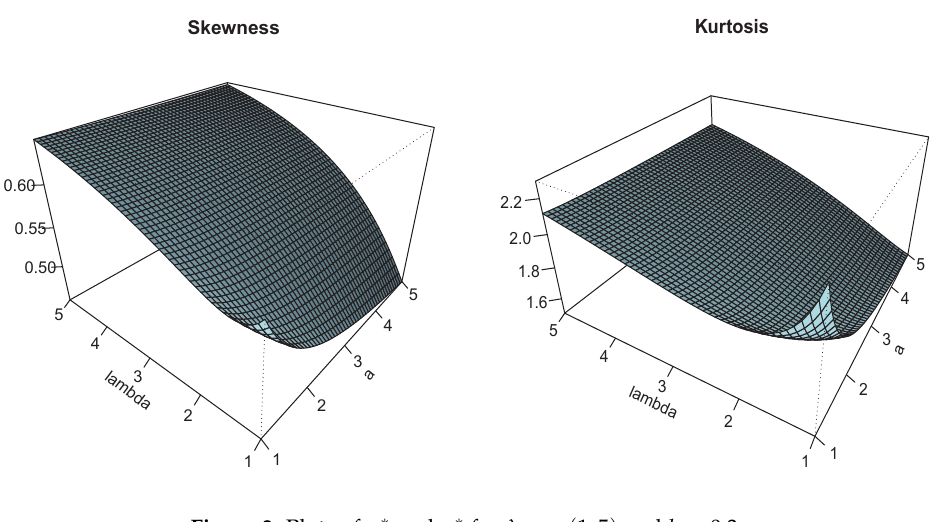
Figure 3. Plots of γ ∗